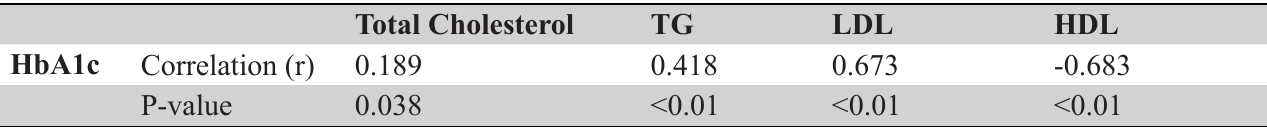
Table 5. Correlations of HbA1c to lipid profile level.